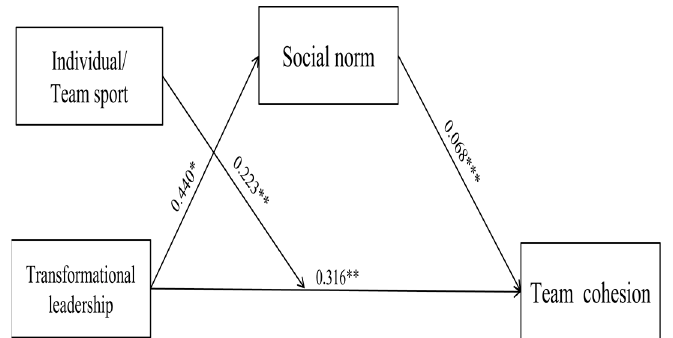
Figure 1. Finalized hypothesized model. Note. The values presented in this figure are